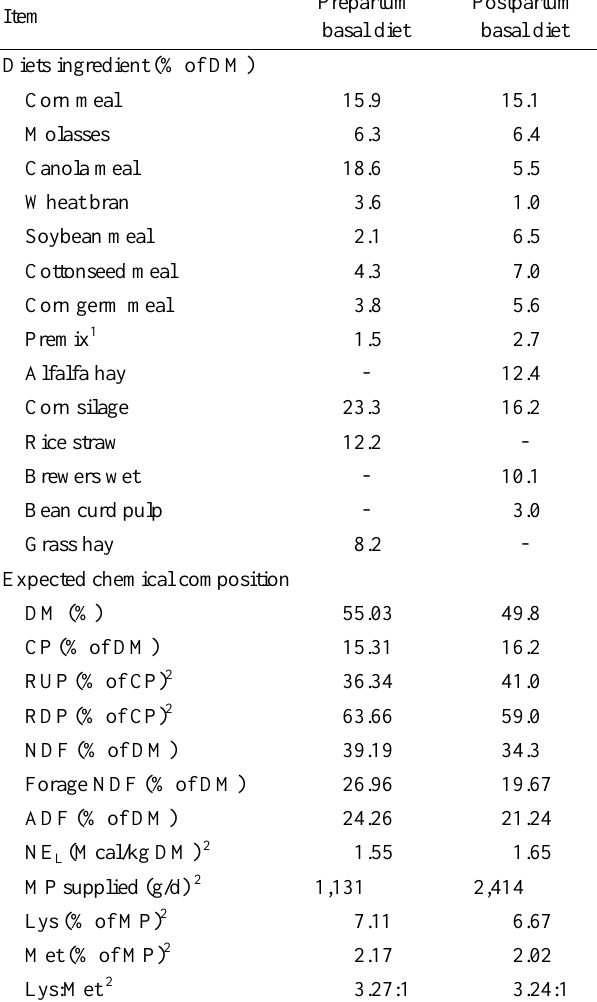
Table 1. Formulation and composition of pre- and postpartum basal